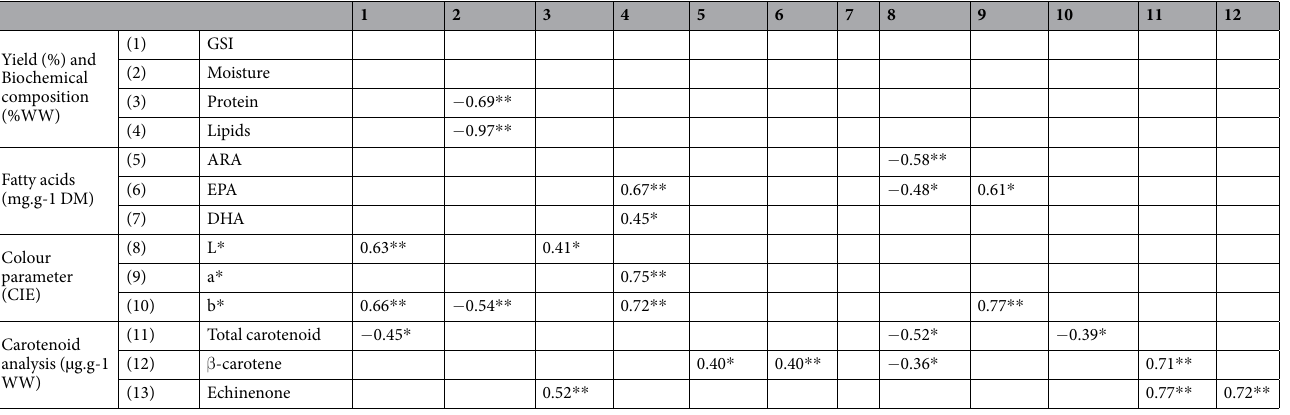
Table 1. Values of Pearson’s correlation coefficients between yield, biochemical composition and colour determination (carotenoids and CIE parameters) of P . lividus gonads determined for a 5-month period. N = 30, for the five months analysed: April, June, September and November 2016 and February 2017. ** P < 0.01 (two- tailed) and * P < 0.05 (two-tailed); bold values indicate negative